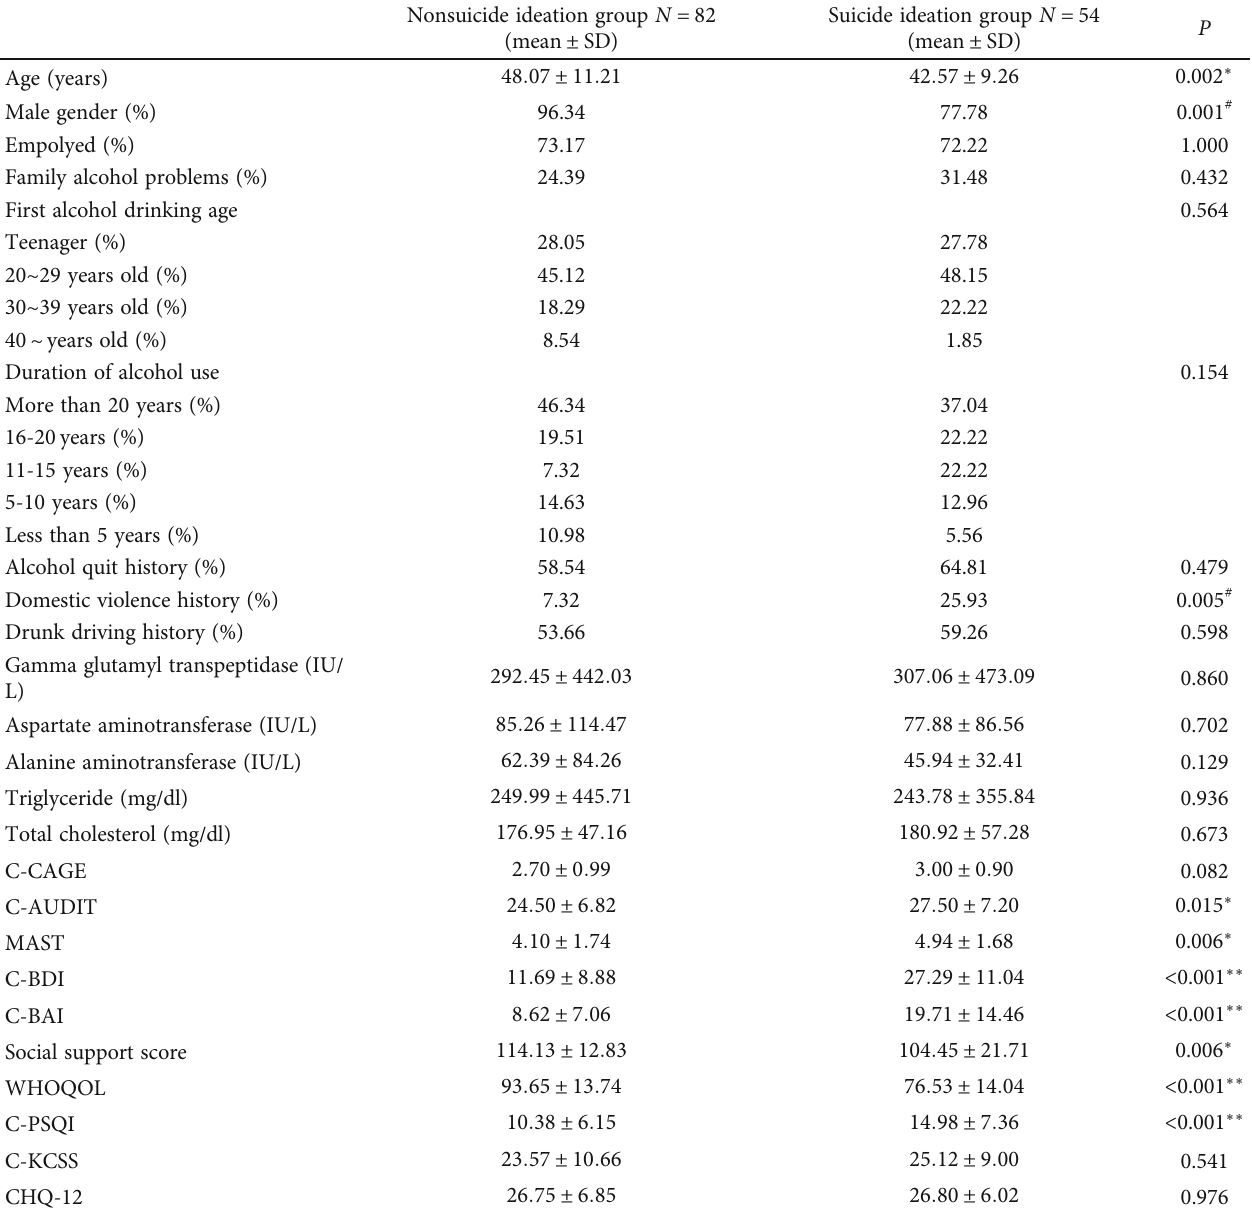
Table 1: Di ff erence between patients in nonsuicide ideation group and patients in suicide ideation group in age, gender, employment, alcohol family history, fi rst alcohol drinking age, alcohol use duration, alcohol quit history, domestic violence history, drunk driving history, gamma glutamyl transpeptidase, aspartate aminotransferase, alanine aminotransferase, triglyceride, total cholesterol, C-CAGE, C- AUDIT, MAST, C-BDI, C-BAI, social support score, WHOQOL, C-PSQI, C-KCSS, and